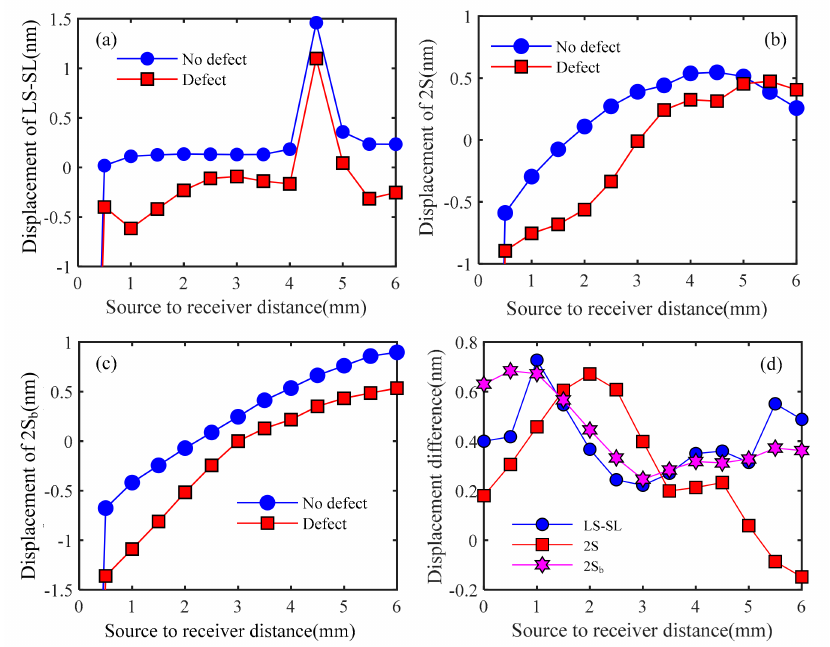
Figure 8. Comparison of displacement of ultrasonic waves in different modes in good model and a model with delamination: ( a ) LS-SL, ( b ) 2S, ( c ) 2S b , and ( d ) Displacement differences of the LS-SL, 2S, and 2S b in the models without and with